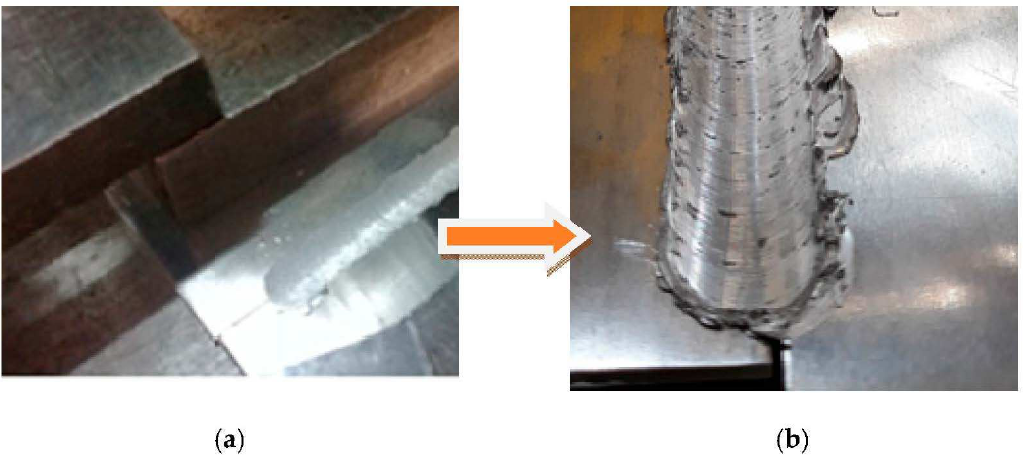
Figure 17. End areas of the joint. ( a ) heterogeneous joining obtaoned with FSW process. ( b ) flashing at the end of the joining.